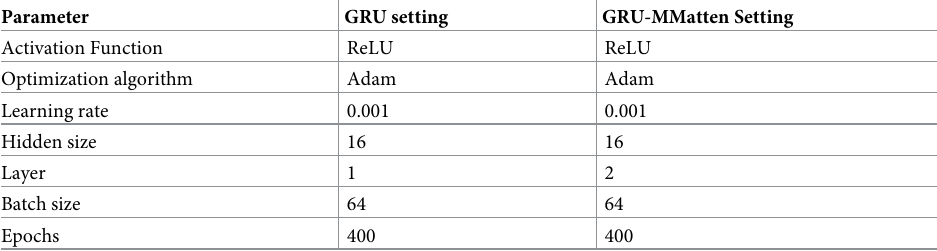
Table 2. Neural network hyperparameters.